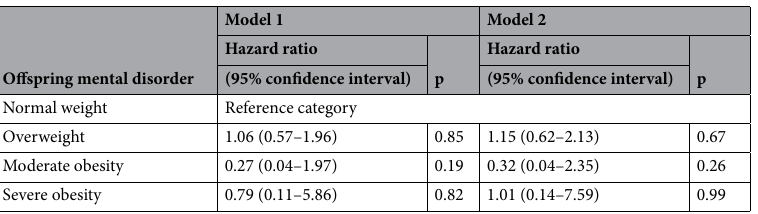
Table 5. Maternal body mass index in pregnancy and hazard of mental disorders in offspring born 1975– 1999. Model 1 is adjusted for sex and birth year of the child and gestation when weight was measured. Model 2 is adjusted also for maternal smoking and hypertensive disorders in pregnancy, maternal hospital-treated and self-reported mental disorders, age at delivery, parity and the social class of the family. NA not